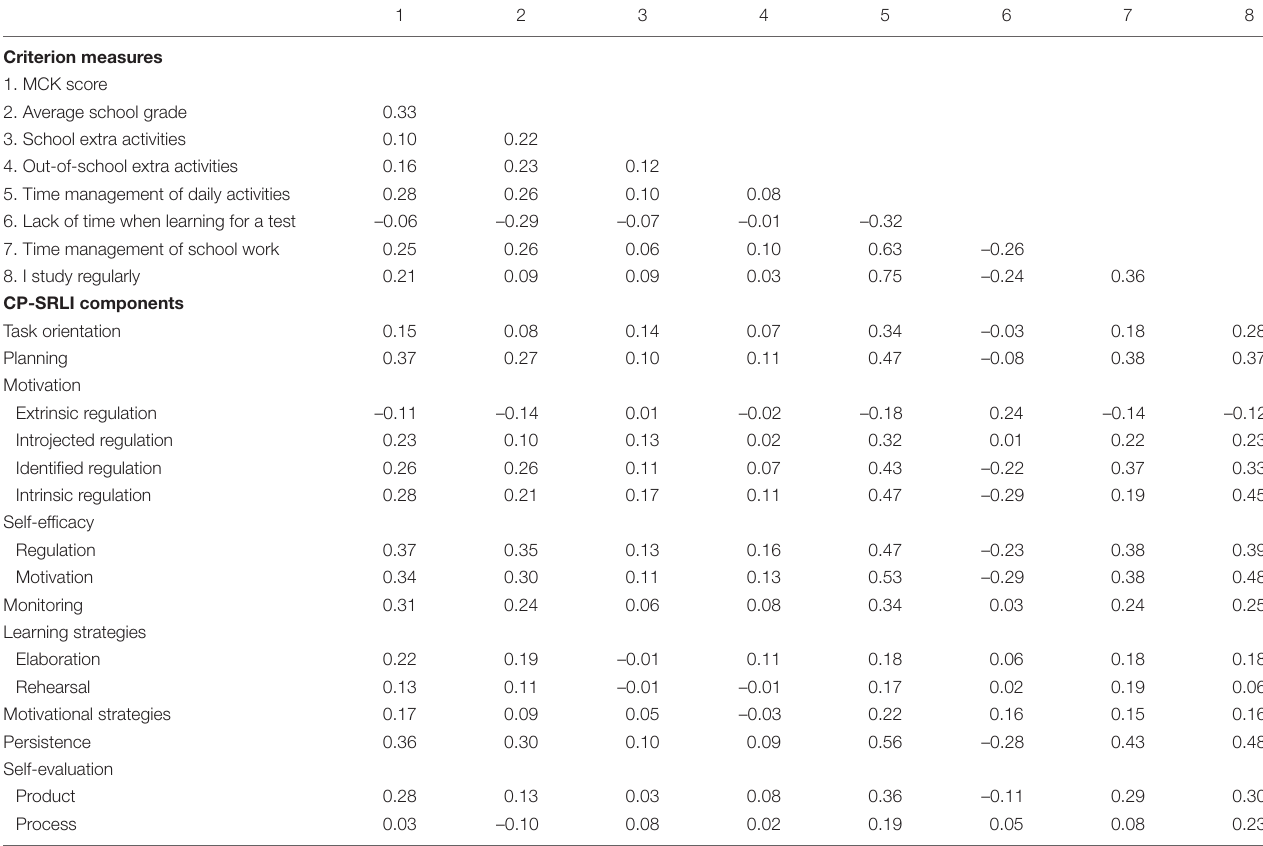
TABLE 4 | Intercorrelations among the criterion measures, and their correlations with the CP-SRLI components. 1